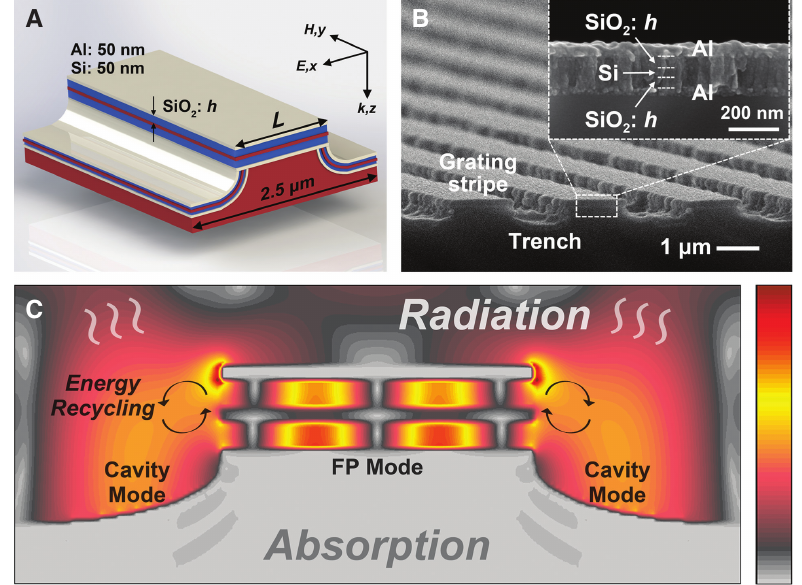
Figure 1: Schematic and physical illustrations of the designed multilayer trench gratings. (A) Schematic diagram of a unit cell of the designed structure. (B) Cross-sectional SEM image of the microstructure, and the inset exhibits the detail of fabricated multilayer MDD configuration. (C) Working principle diagram of the designed structure. The normalized color bar ranges from 0 to 1 for gray and red,